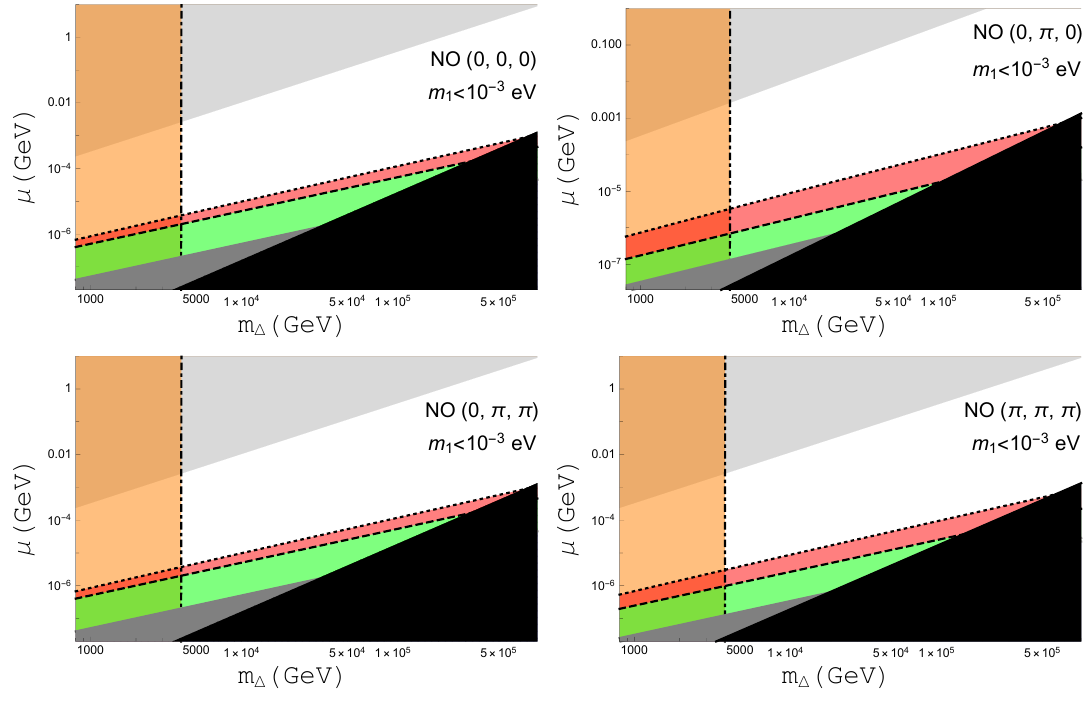
Figure 9 . The experimental sensitivities of LFV searches for the successful Type II Seesaw Leptogenesis parameter space is depicted for different CP phases parameter sets ( δ CP , α 21 , α 31 ) in the NO scenario with small m 1